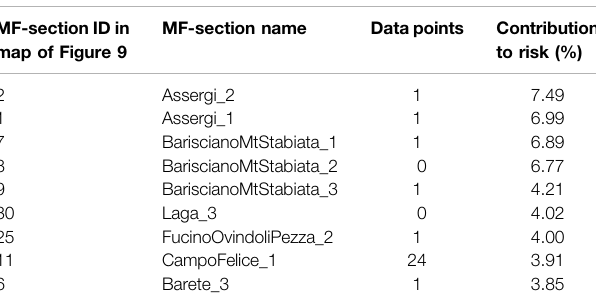
TABLE3| NumberofslipratedatapointsavailableintheFault2SHACADforeach MF-sectionparticipatingtotheupper10%ofthedistributionofthetypological risk at L ’ Aquila ordered by % of